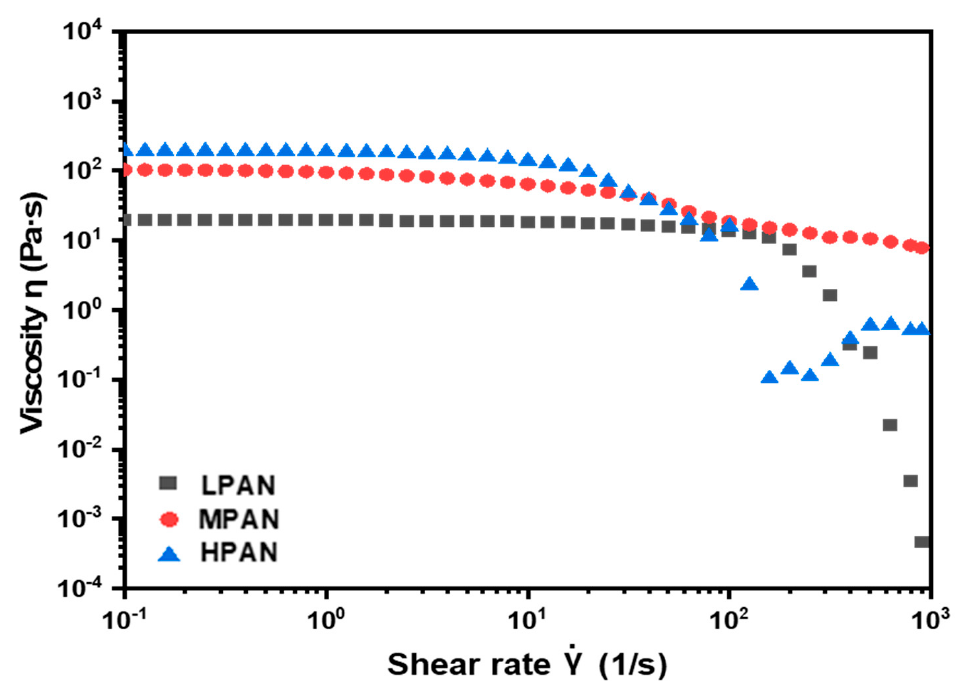
Figure 3. Viscous behavior of each PAN copolymer dope.